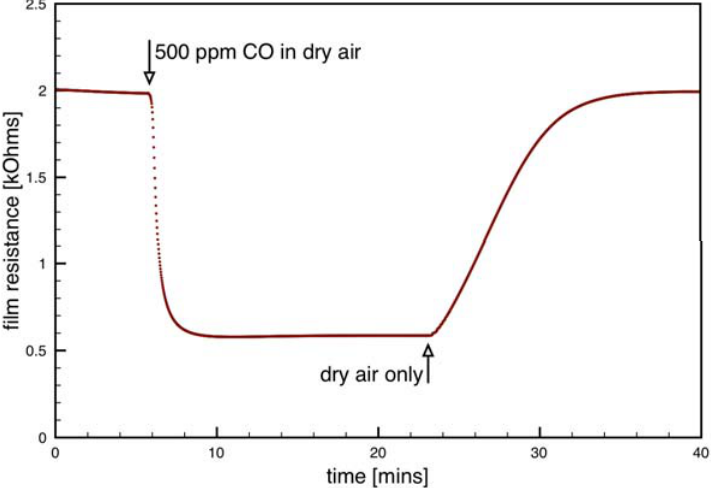
Figure 9. Typical sensor response for a dispersion-drop sensor at an operating temperature of 330 °C.